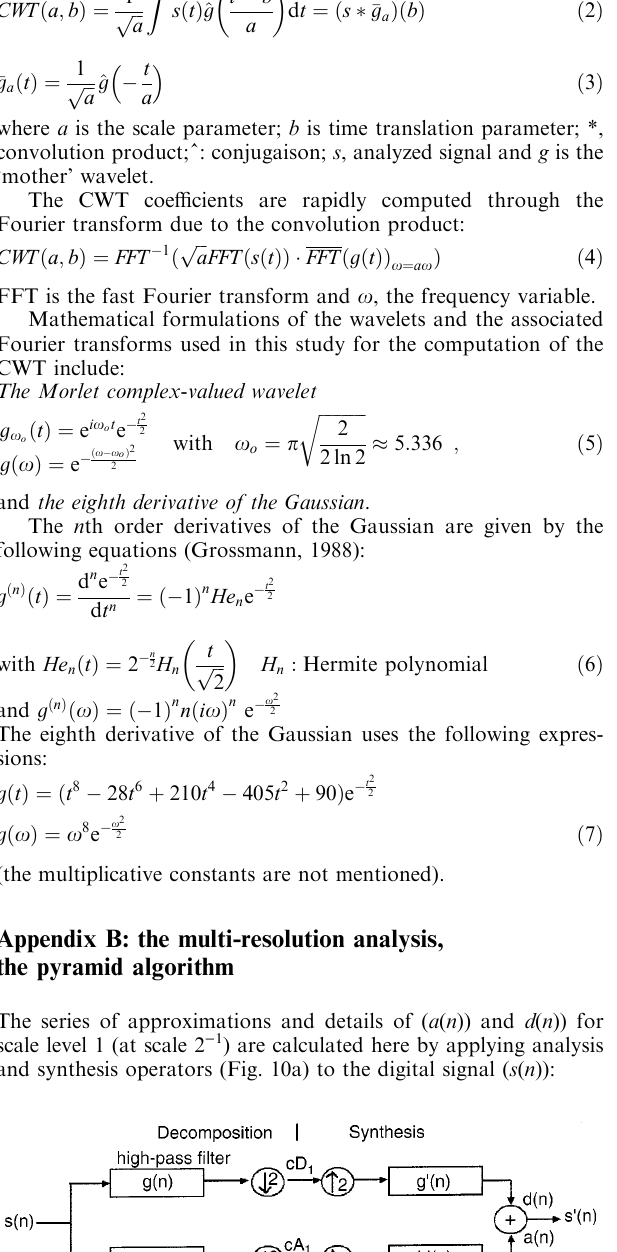
, and cA denote 1 1